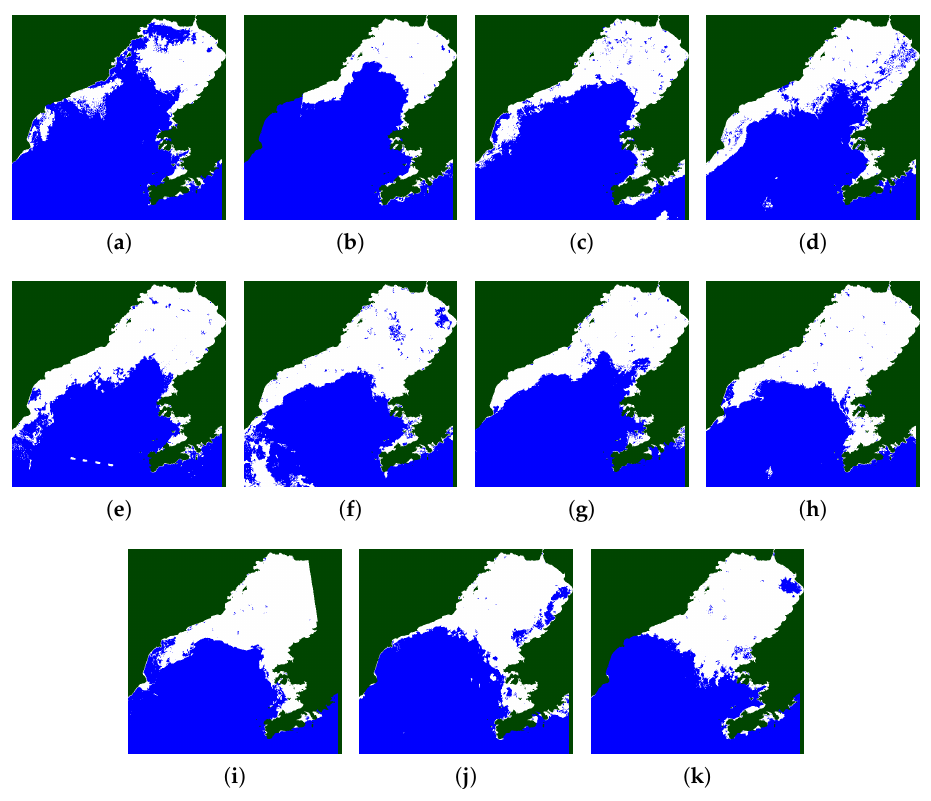
Figure 12. Open-water (blue) and sea ice (white) discrimination for the RADARSAT-2 SAR imagery: ( a ) 2 january 2013; ( b ) 6 January 2013; ( c ) 9 January 2013; ( d ) 16 January 2013; ( e ) 23 January 2013; ( f ) 26 January 2013; ( g ) 2 February 2013; ( h ) 9 February 2013; ( i ) 12 February 2013; ( j ) 16 February 2013; ( k ) 19 February 2013; using the 50% threshold for the ice concentration. The green indicates either land or areas of no SAR